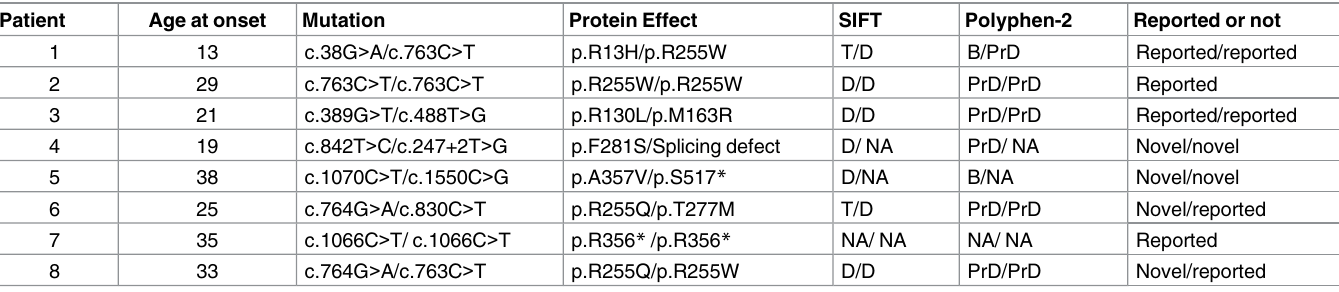
Table 1. BEST1 mutations identified in the